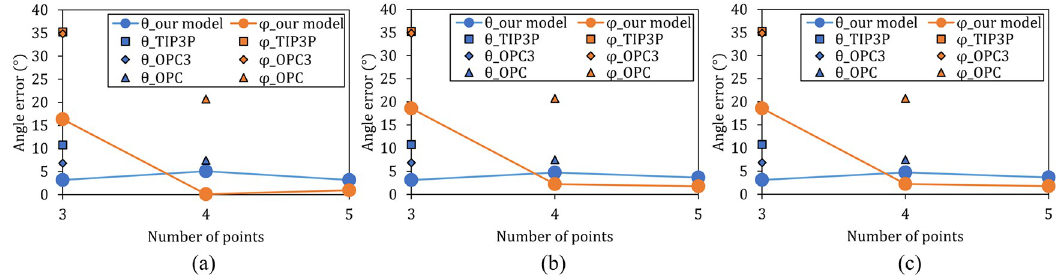
Fig 9. Errors in reproducing the ab initio water dimer geometry by the rigid water models. Our models’ θ and φ angle errors (reference values— θ 0 = 57.9˚ and φ 0 = 55.6˚—are from the benchmark ab initio calculation by Klopper et al. [39]) are represented with blue and orange connected circles. In (a), (b) and (c) are the results of models built with gas exp., gas QM and liquid MP2/4MM multipole moments (Table 1) respectively. Water dimers of TIP3P, OPC3 and OPC model are energy minimized with O-O distance fixed at 2.91 Å , and their angle errors in the dimers are shown as square, diamond and triangle